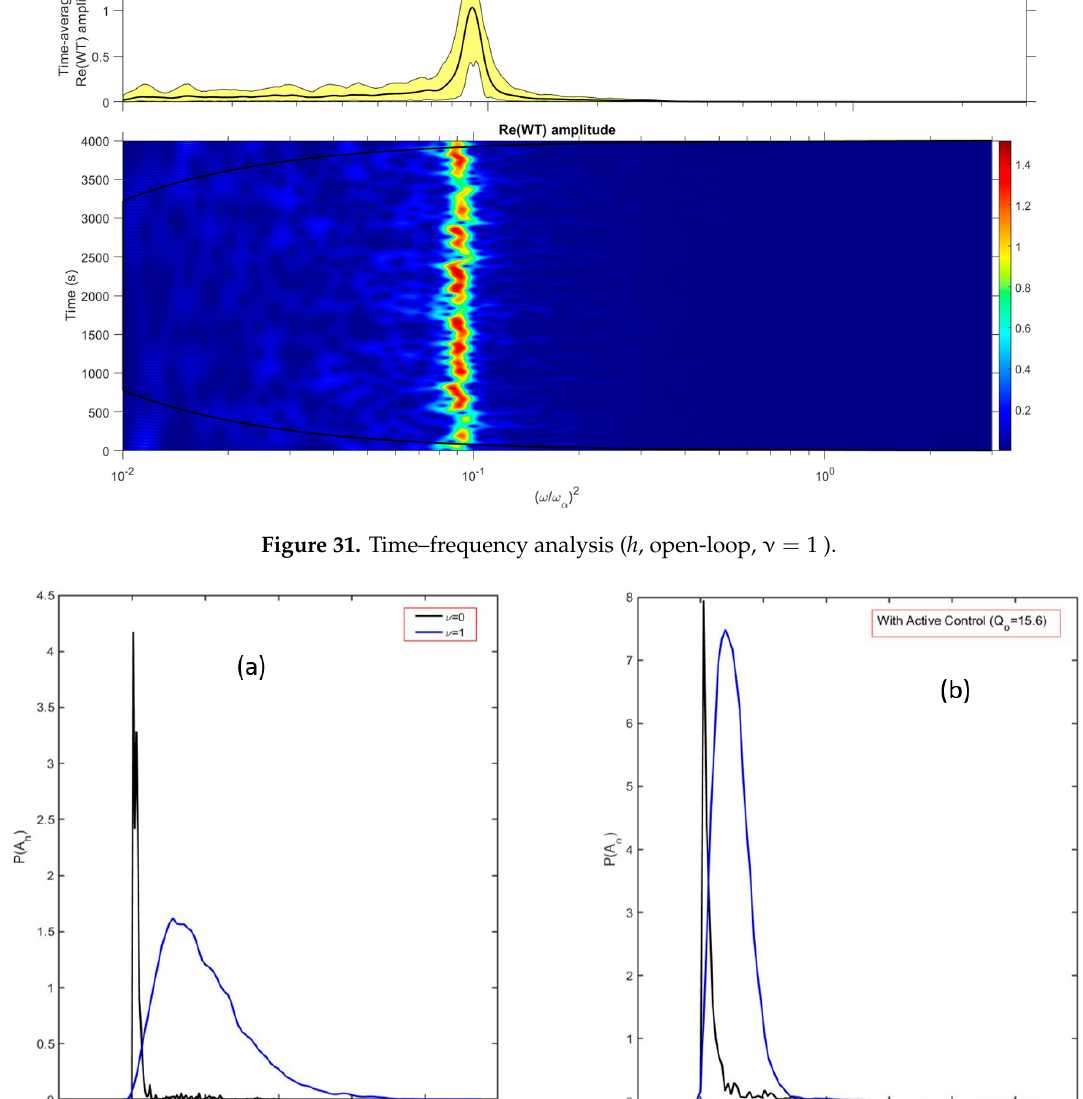
Figure 33. Effect of noise on torsional displacement with active control.